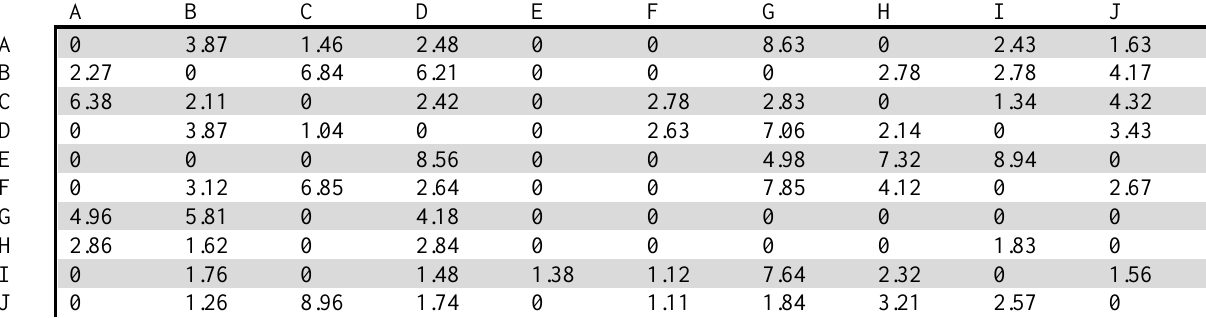
Initial direct relations matrix